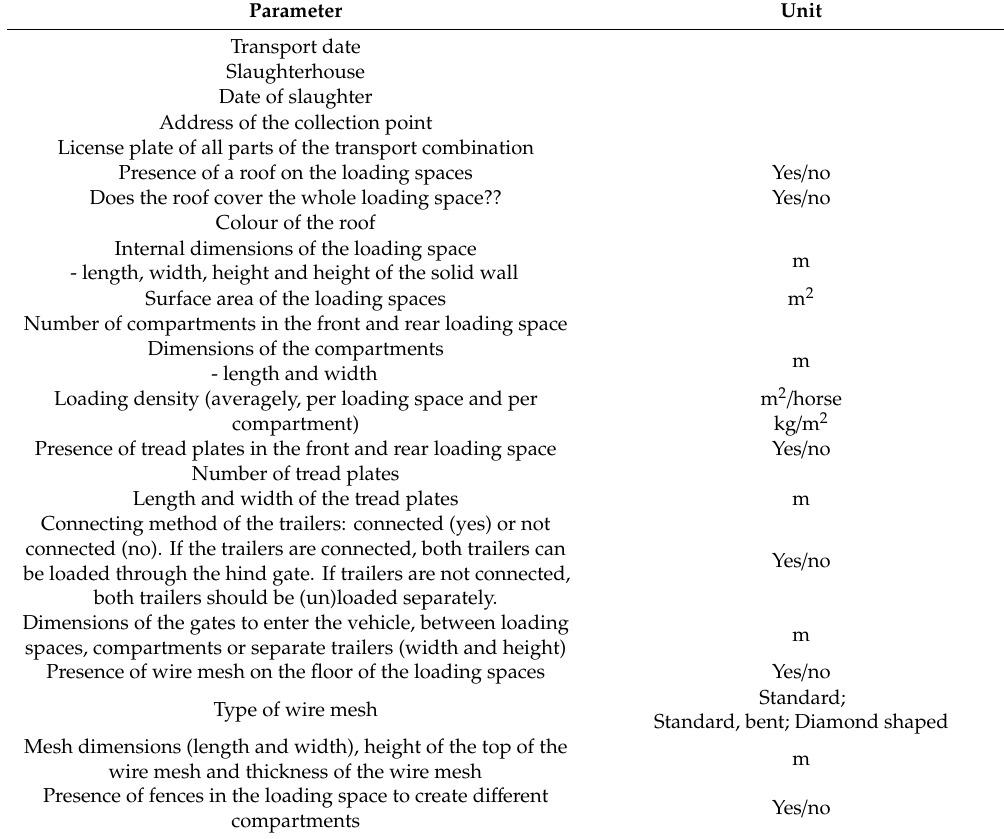
Table A1. Observed parameters of the transport and transport